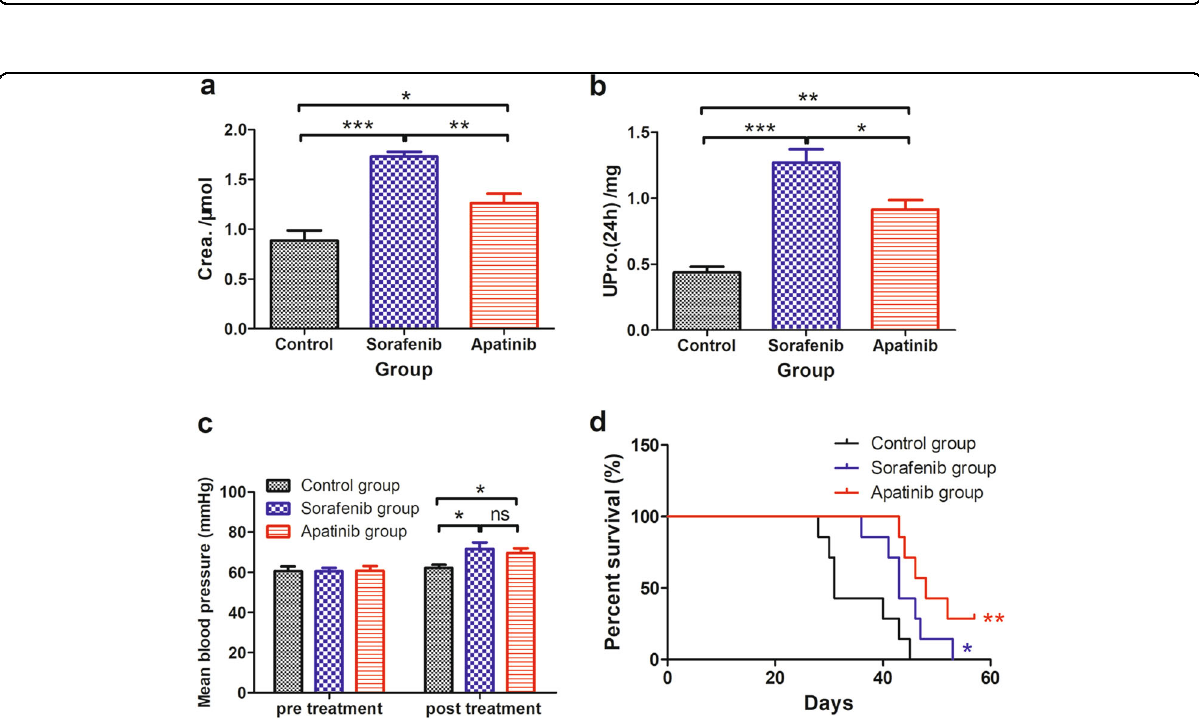
Fig. 6 Side effects in the control and sorafenib and apatinib treatment groups. a The 24-h urine creatinine (Crea) on day 20 post-treatment ( n = 4). b The 24-h urine protein (UPro) on day 20 post-treatment ( n = 4). c Mean blood pressure pretreatment and post-treatment (day 10) ( n = 7). d Survival rate ( n = 7). (*) P < 0.05, (**) P < 0.01, (***) P < 0.001, (ns) non-signi fi cant, P ≥